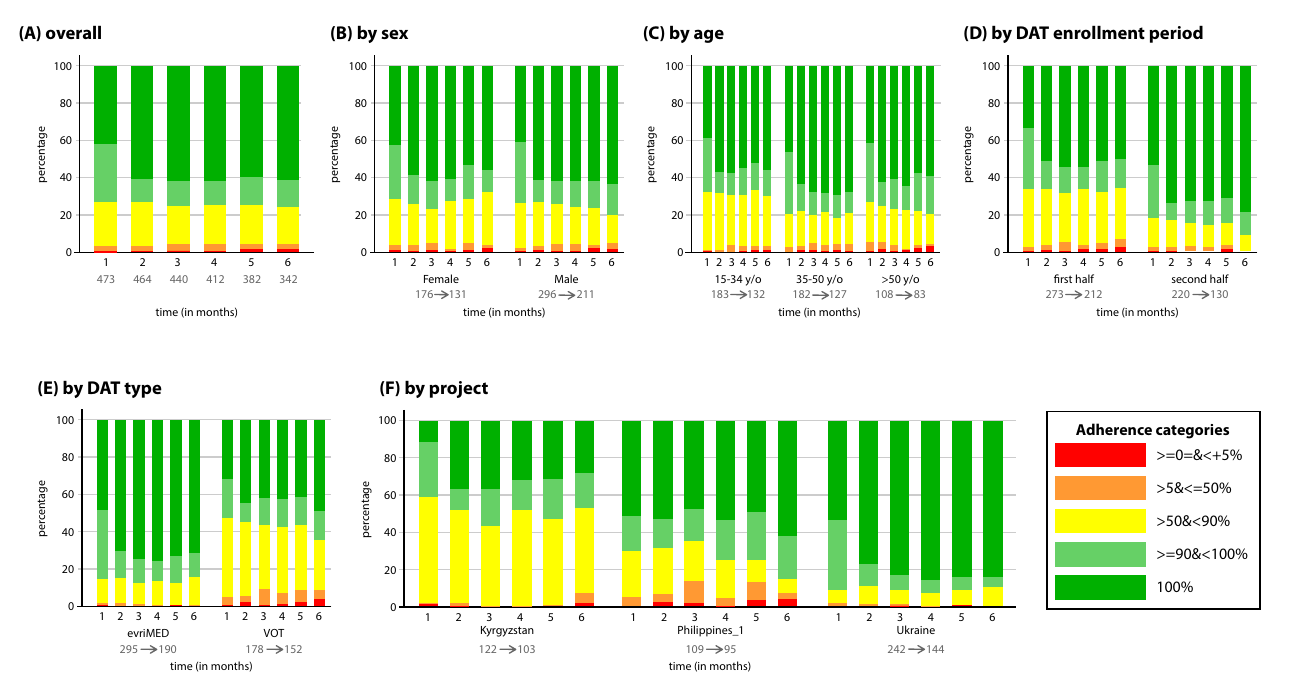
Figure 2. Frequency graphs of TB treatment adherence categories for DR-TB population over the (first) six treatment months. The proportion of patients belonging to a certain adherence category is depicted on the y -axis, and the six treatment months are depicted on the x -axis. ( A ) Monthly adherence for all patients. ( B ) Monthly adherence split up by sex. ( C ) Monthly adherence split up by age category. ( D ) Monthly adherence split up by DAT enrollment period. ( E ) Monthly adherence split up by DAT type. ( F ) Monthly adherence split up by project. Underneath each subgroup two numbers are placed; these resemble the sample size at month one (before arrow) and month six (after arrow). Number of patients at each month is given in the overall graph. DAT = digital adherence technology; VOT = video-observed therapy; y/o = years